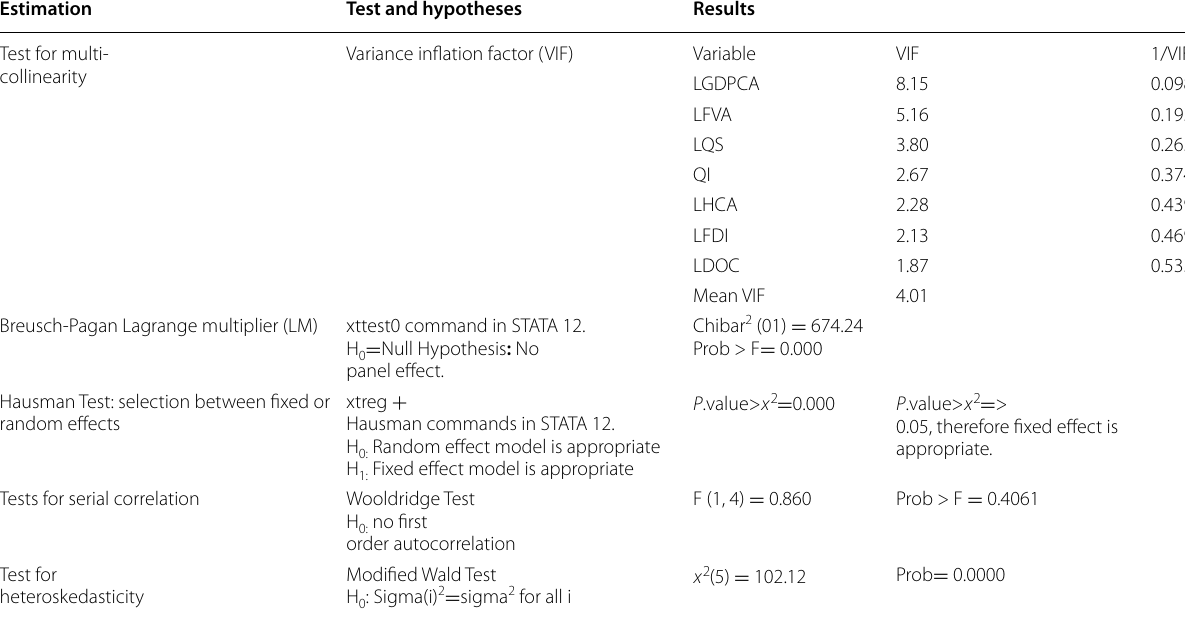
Table 4 Tests for panel data estimation techniques Estimation